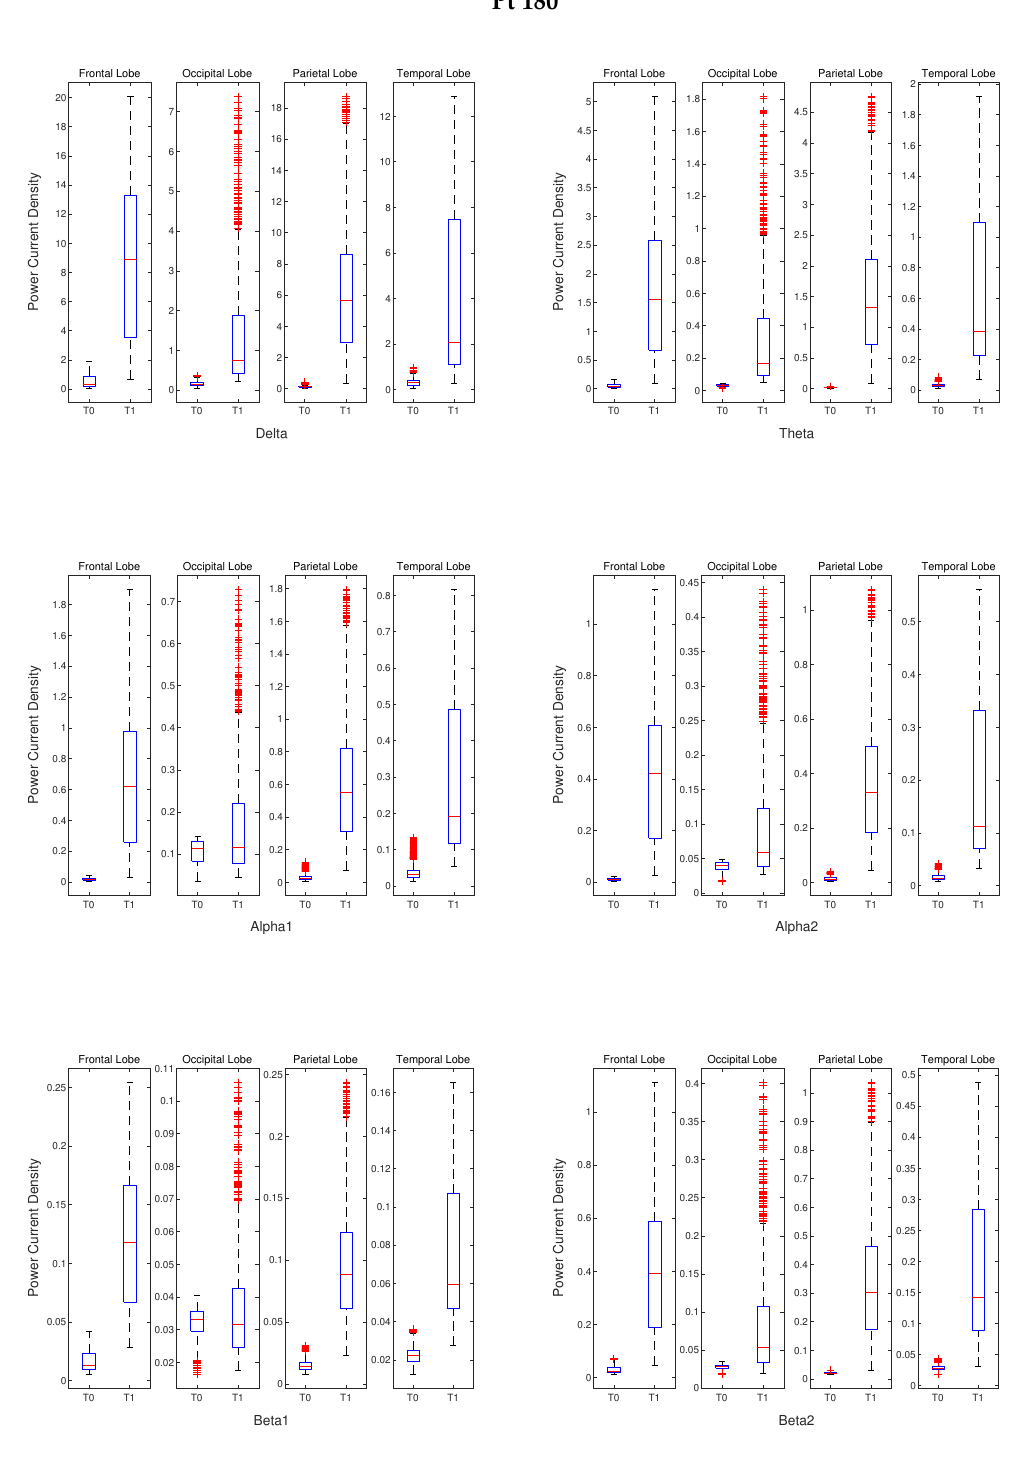
Figure 8. Boxplot of the power current density of patient 180 at time T0 and T1 for each frequency sub-band and each region of interest (frontal, occipital, parietal, and